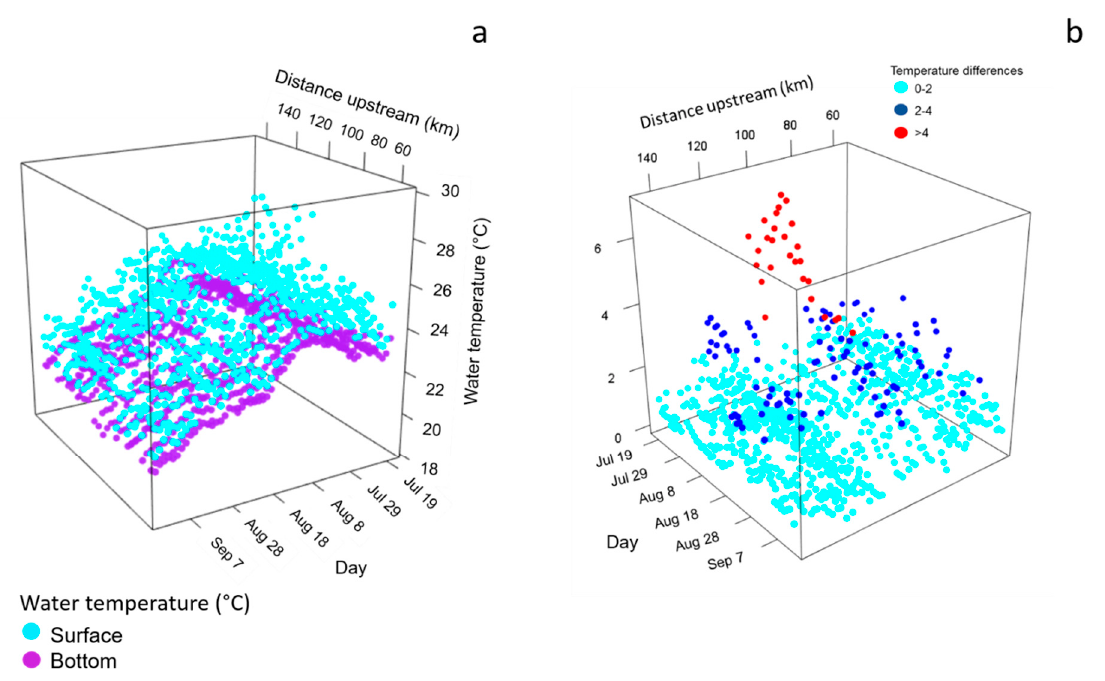
Figure 4. Patterns of longitudinal thermal heterogeneity ( a ) of the Pend Oreille River measured with instream maximum and minimum temperature loggers deployed from 17 July to 14 September 2017, and ( b ) maximum di ff erences between surface water temperature and bottom water temperature observed from instream temperature loggers deployed along the longitudinal profile ( b ). See Supplementary Material S2 for R code to generate graphics for interactive visualization in three-dimensional space.